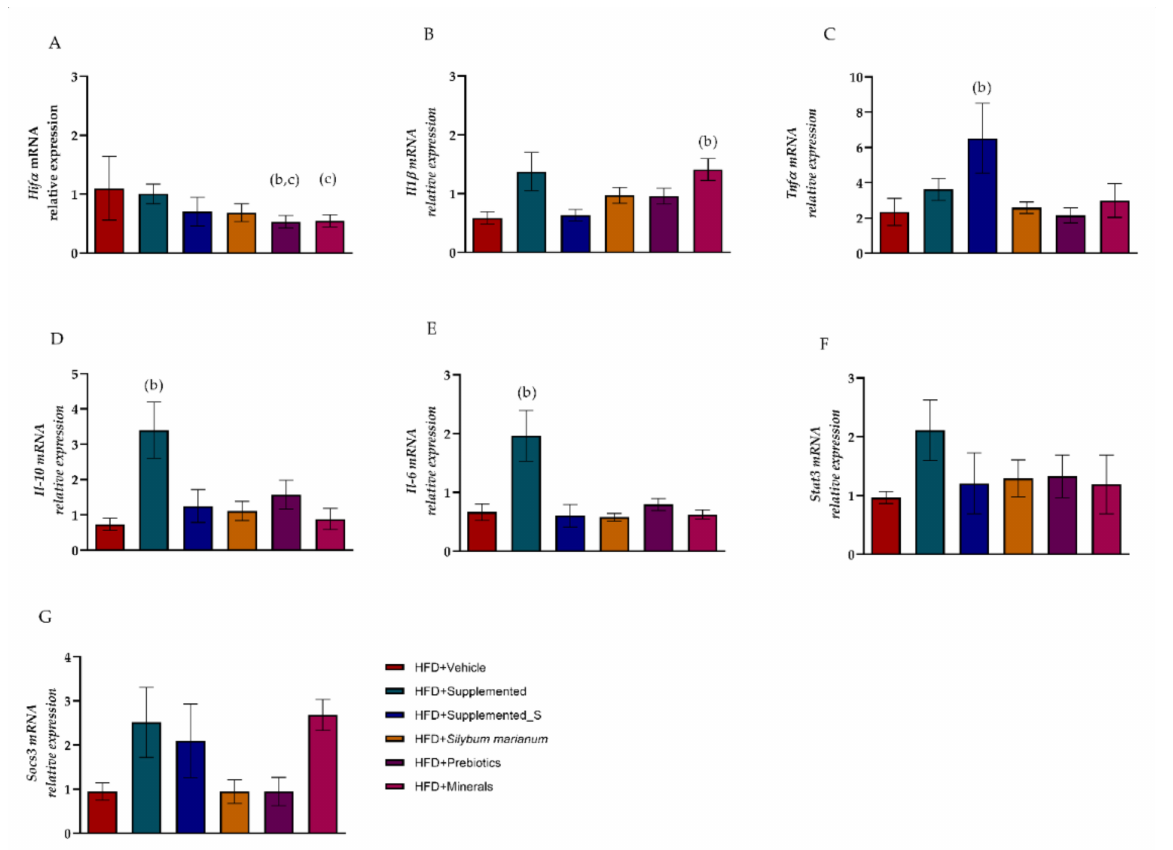
Figure 8. Liver expression of genes related to cytokines. Liver mRNA expression is determined by quantitative PCR. Differences were seen in: ( A ) Hif α ; ( B ) Il1 β ; ( C ) Tnf α ; ( D ) Il10 ; ( E ) Il6 ; ( F ) Stat3 ; ( G ) Socs3 . Significant p < 0.05 in one-way ANOVA followed by Tukey’s (parametric) ( A – D , F , G ) or Müller Dunn’s (nonparametric) ( E ) post-hoc test (n = 4–8 per group). Means and standard deviations were used to generate the effect size estimates (Hedge’s g): (b) versus HFD + Vehicle; (c) versus HFD + Supplemented. HFD=high-fat diet. The housekeeping gene was B2m . Values are means ±